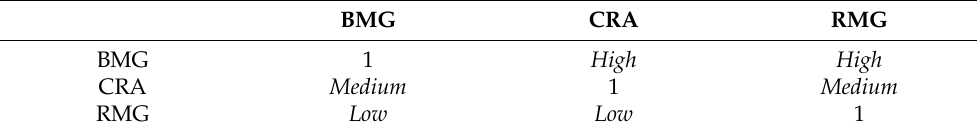
Table 1. Cost matrix for amorphous alloy phase